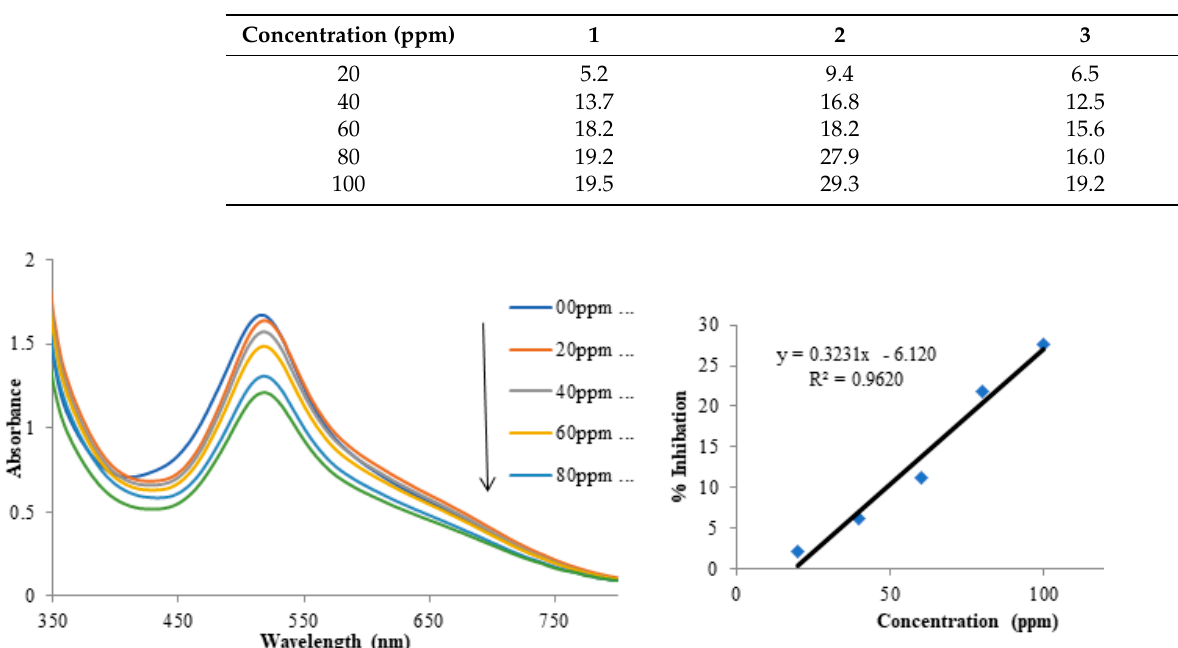
Table 3. DPPH radical scavenging activities (% RSA) of compound ( 1 – 3 ).